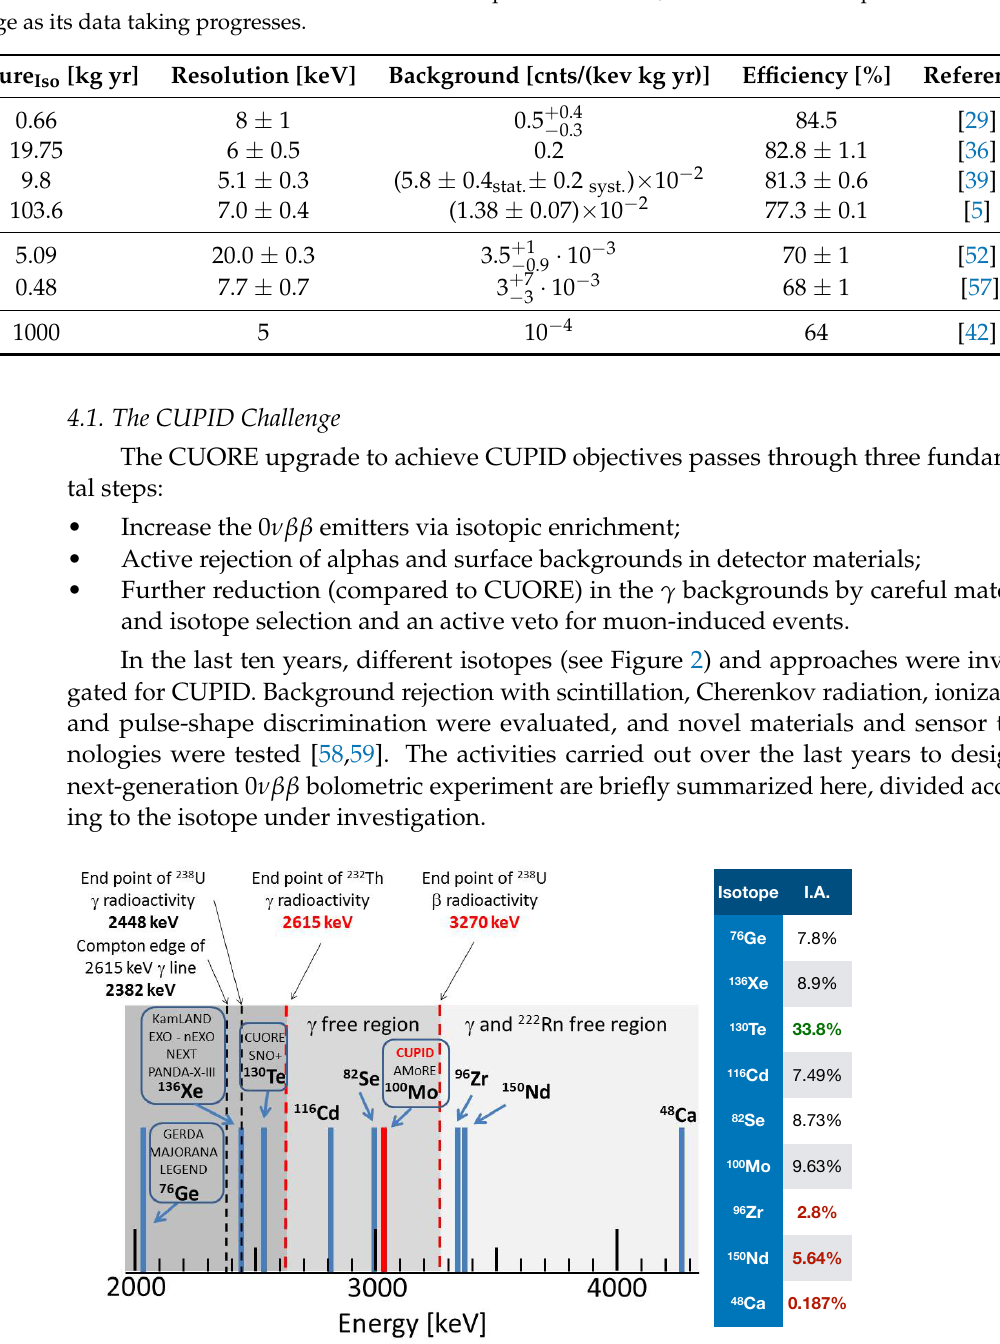
Figure 2. Expected energy signature in the two-electron sum-energy spectrum for the nine most suitable double-beta emitters. These are compared with background energy markers related to the maximum γ energies of the 238 U and 232 Th chains and the maximum β energy of the 238 U chain. The main experiments are also mentioned in relation with their selected nucleus. For essentially technical reasons, most searches investigate the three least favorable isotopes. The isotope selected for the CUPID baseline is 100 Mo. We also report the natural isotropic abundance [14]. The most favorable isotopes from the point of view of the background are also those with the lowest isotopic abundance. Figure adapted from